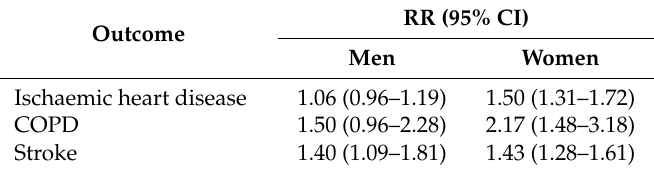
Table 1. Relative risks for the association between SHS exposure and adverse health outcomes 1 .